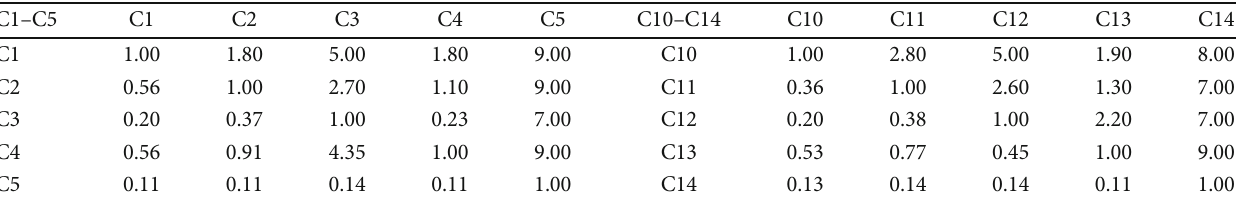
Table 5: C1 – C5 and C10 – C14 attribute judgment